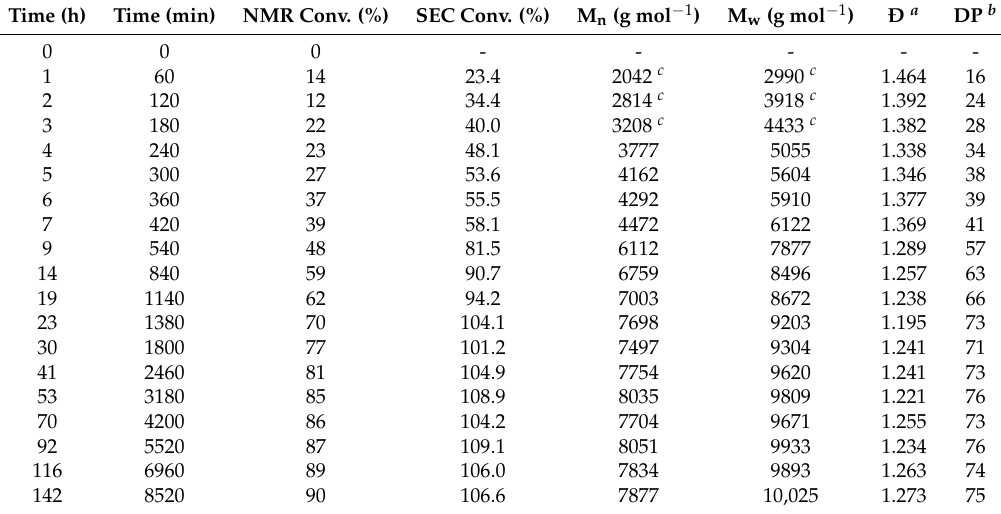
Table A2. Summary of 1 H NMR and SEC data for